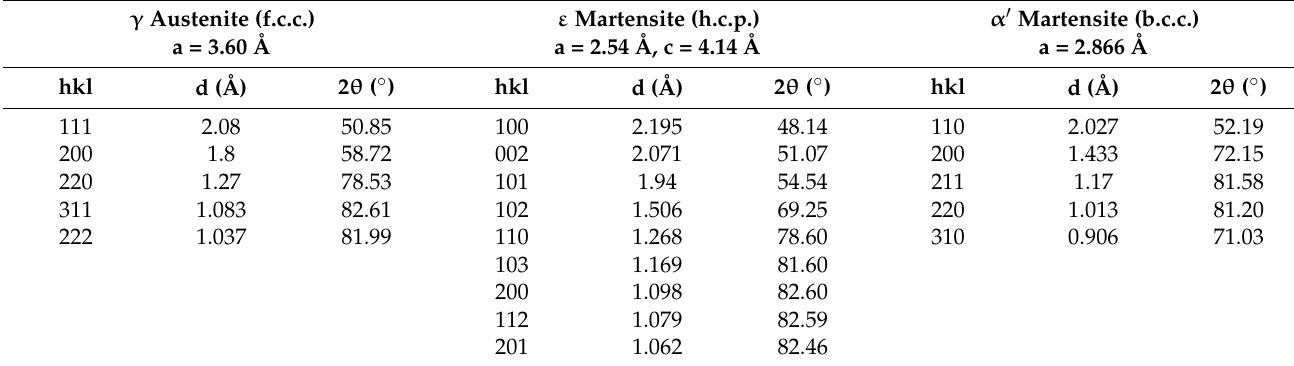
Table 2. X-ray diffraction peaks of γ austenite, ε martensite and α (cid:48)